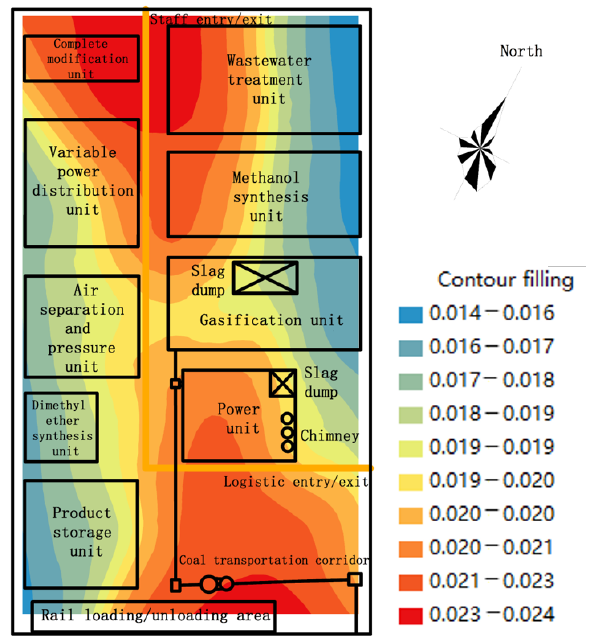
Figure 4. Total hazard quotient risk map for